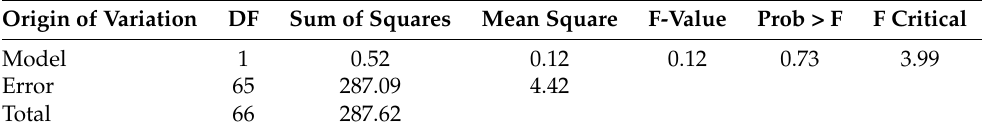
Table 16. ANOVA results for a 0.05 level of significance for the means per academic year. Origin of Variation